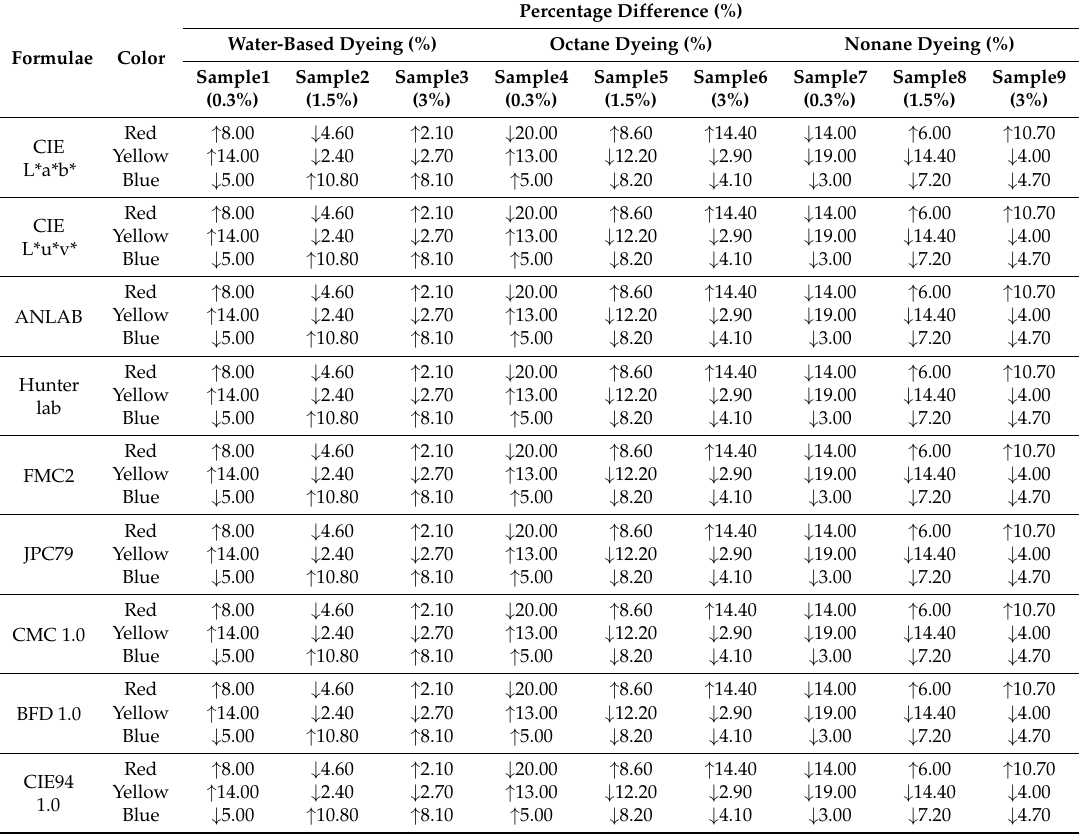
Table 10. Percentage (%) difference of dyed standard wool